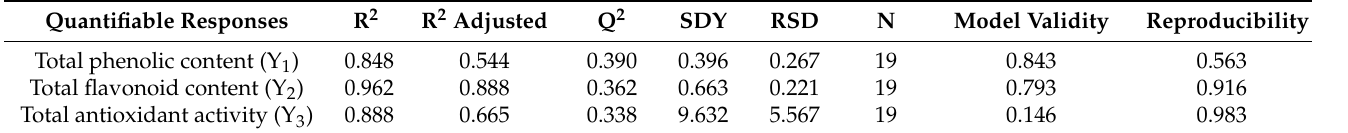
Table 4. The fitting parameters for the evaluated output variables.